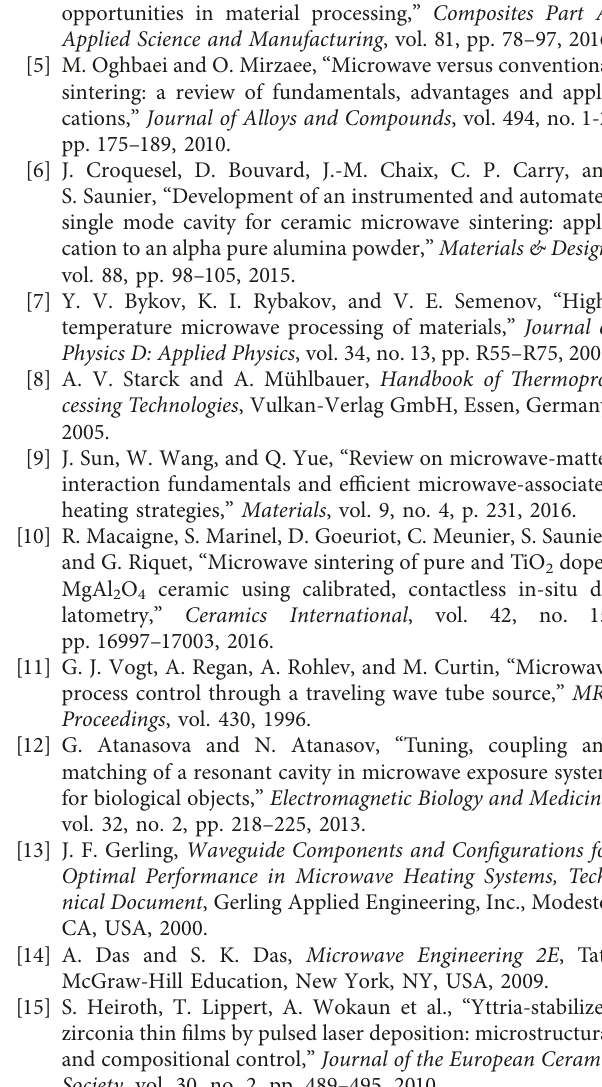
Figure 8: (a) Curves of the set-up and actual temperatures versus time for sintering MgAl showing the spinel-based material samples before and after microwave sintering, and (c) typical SEM microstructure recorded on MgAl 2 O 4 microwave sintered